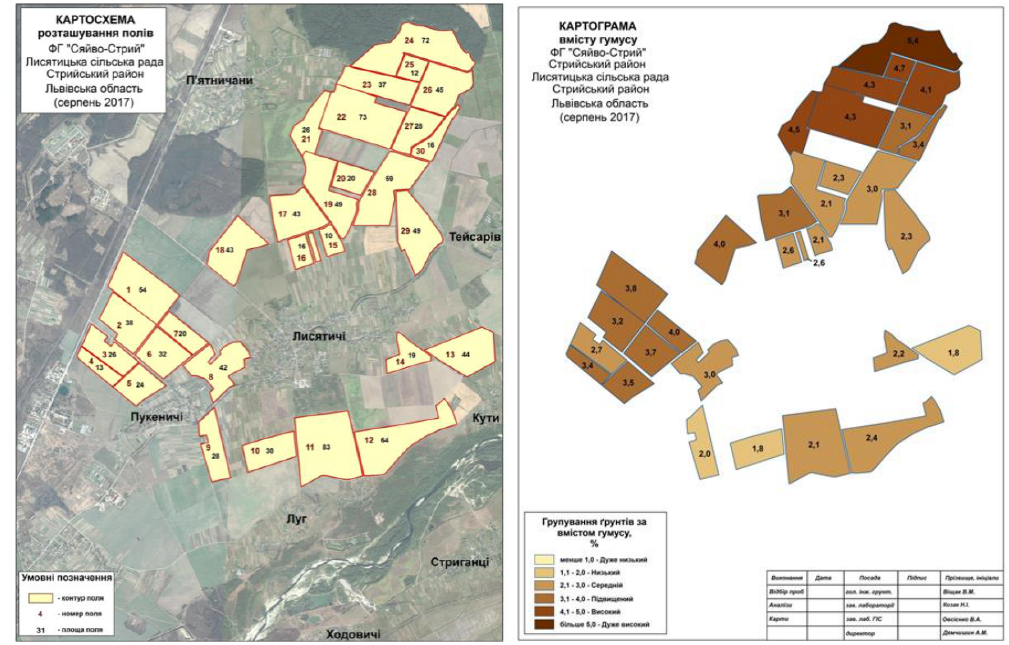
Figure 7. Graphical component of the database on the fields of the “Siaivo-Stryi” farming enterprise. Source: own study.